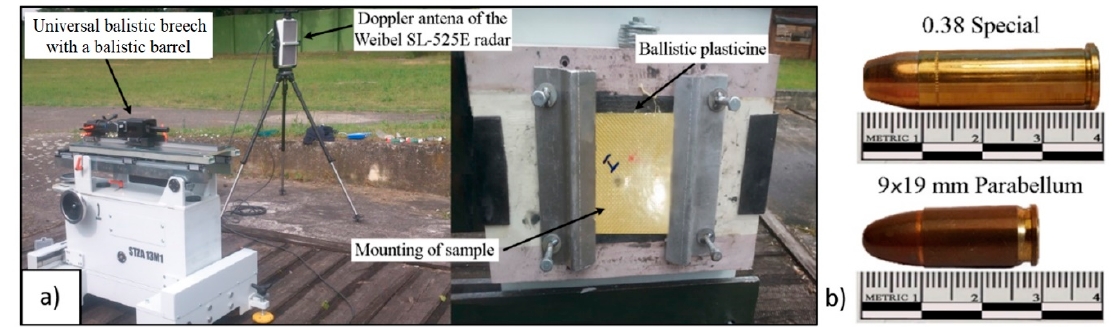
Figure 2. Diagram of the test stand: ( a ) ballistic barrel with accessories and a support for specimen mounting, ( b ) projectile used in the ballistic tests.